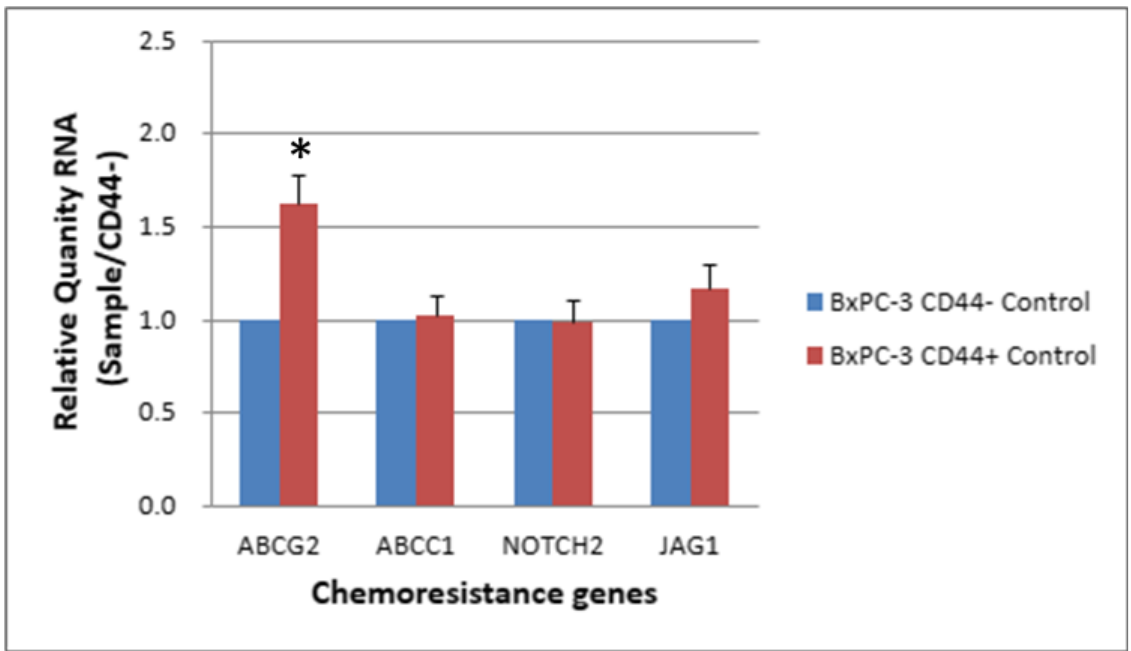
Figure 5. The expression level of 4 chemoresistance genes for non-drug treatment CD44 − cancer stem cells and CD44 − BxPC-3 PDAC cells is shown. The ABCG2 gene had significantly higher expression in CD44+ than CD44 − , * < 0.05. (Mean ± SD).